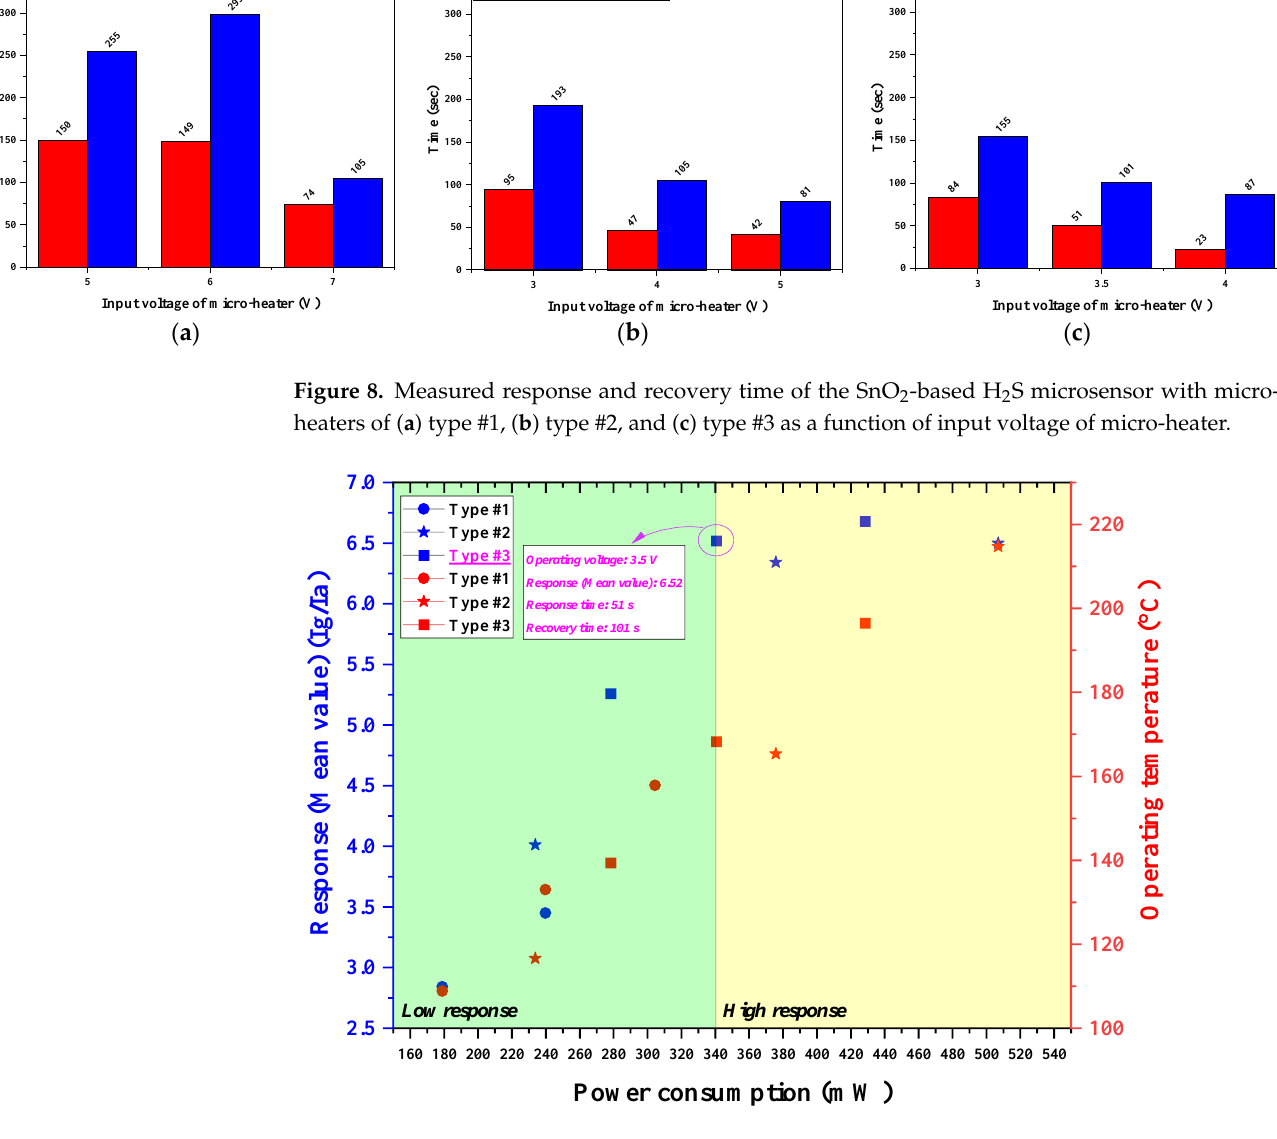
6.52, response time: 51 s, recovery time: 101 s) for portable gas sensor applications, as